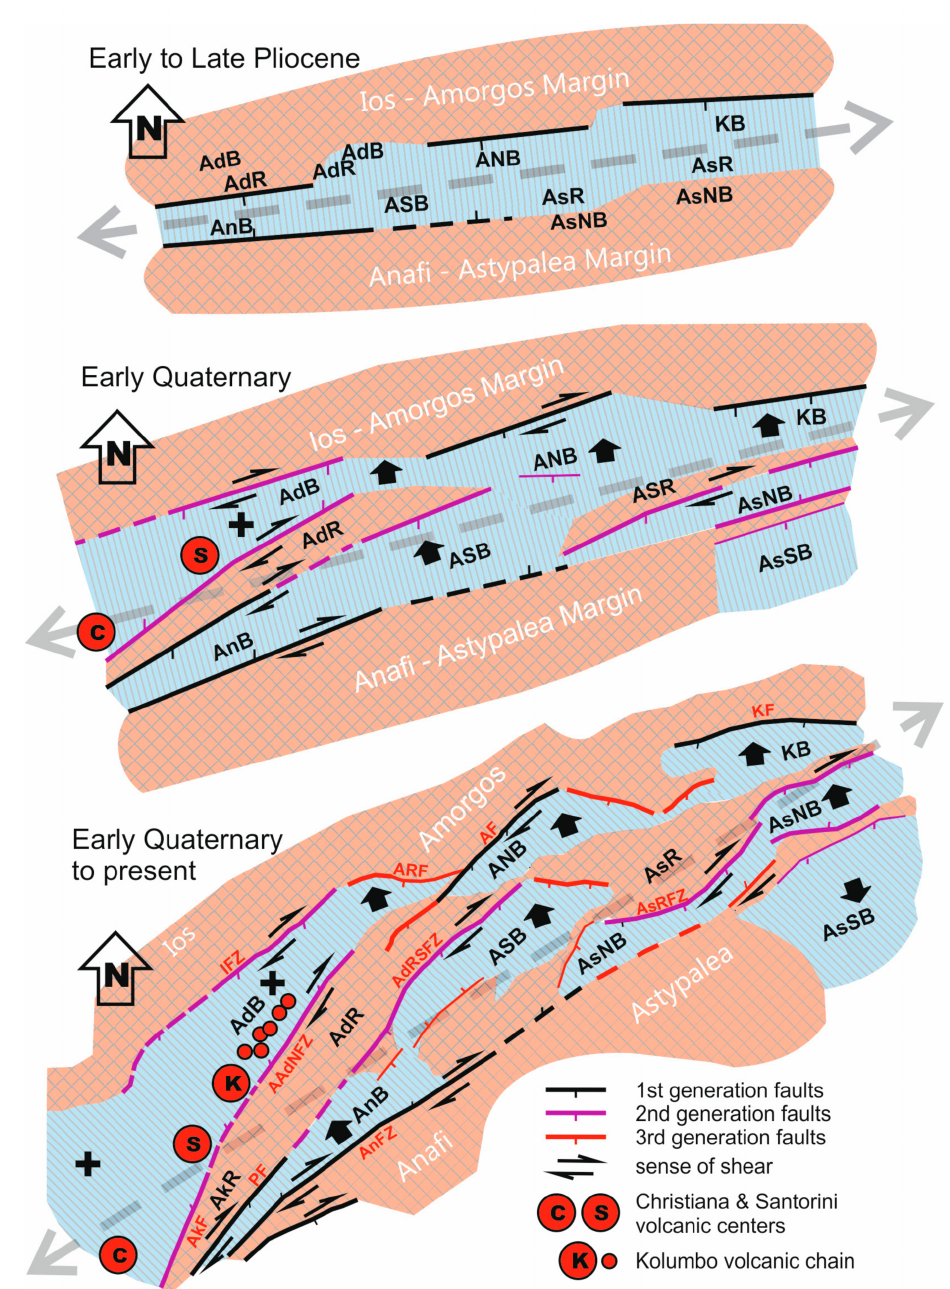
Figure 11. Schematic representation of the evolution of Santorini-Amorgos Shear Zone since Early Pliocene. See text for description and